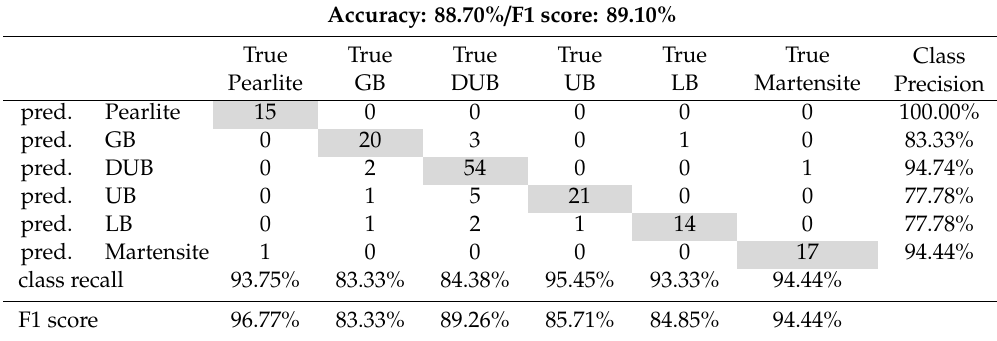
Table 5. Confusion matrix for the classification using multi-scale local binary pattern with a quadratic kernel SVM.